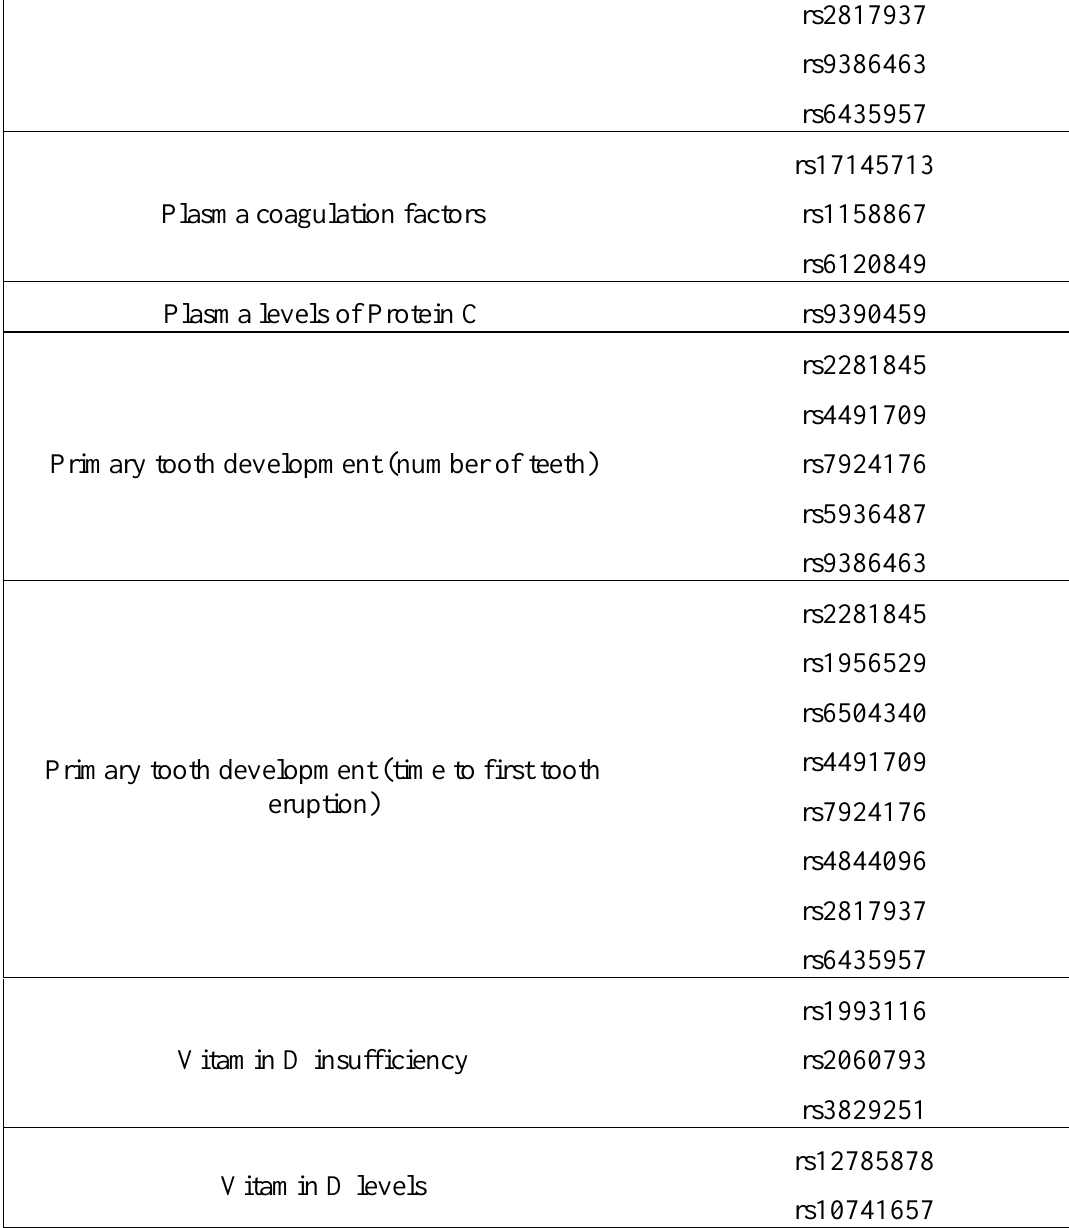
Supplement Table 1. Newly found traits/diseases, SNPs